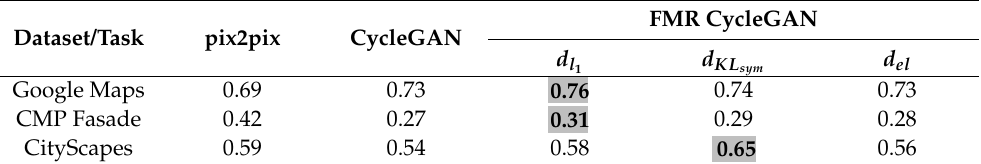
Table 2. SSIM measures for the proposed FMR CycleGAN in comparison to the baseline methods for different used ground distances (the best unsupervised results are highlighted in bold and